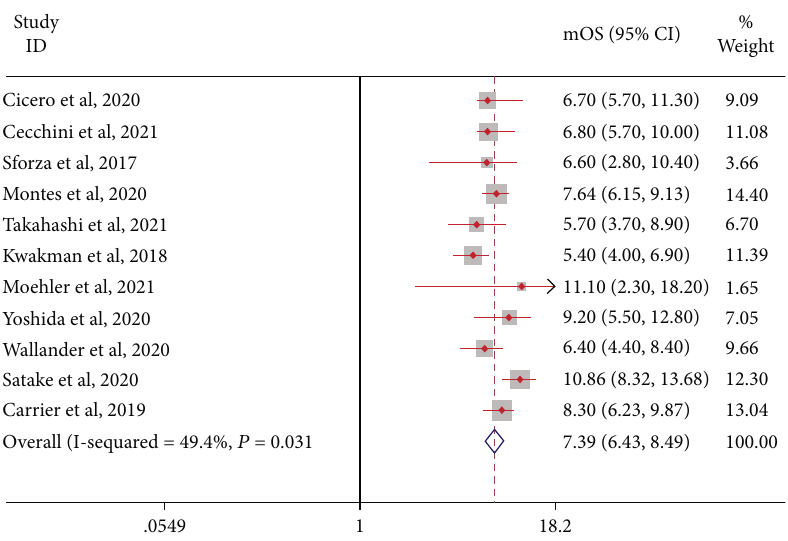
Figure 4: mOS in patients with metastatic colorectal cancer treated with TAS-102 monotherapy or combination therapy with